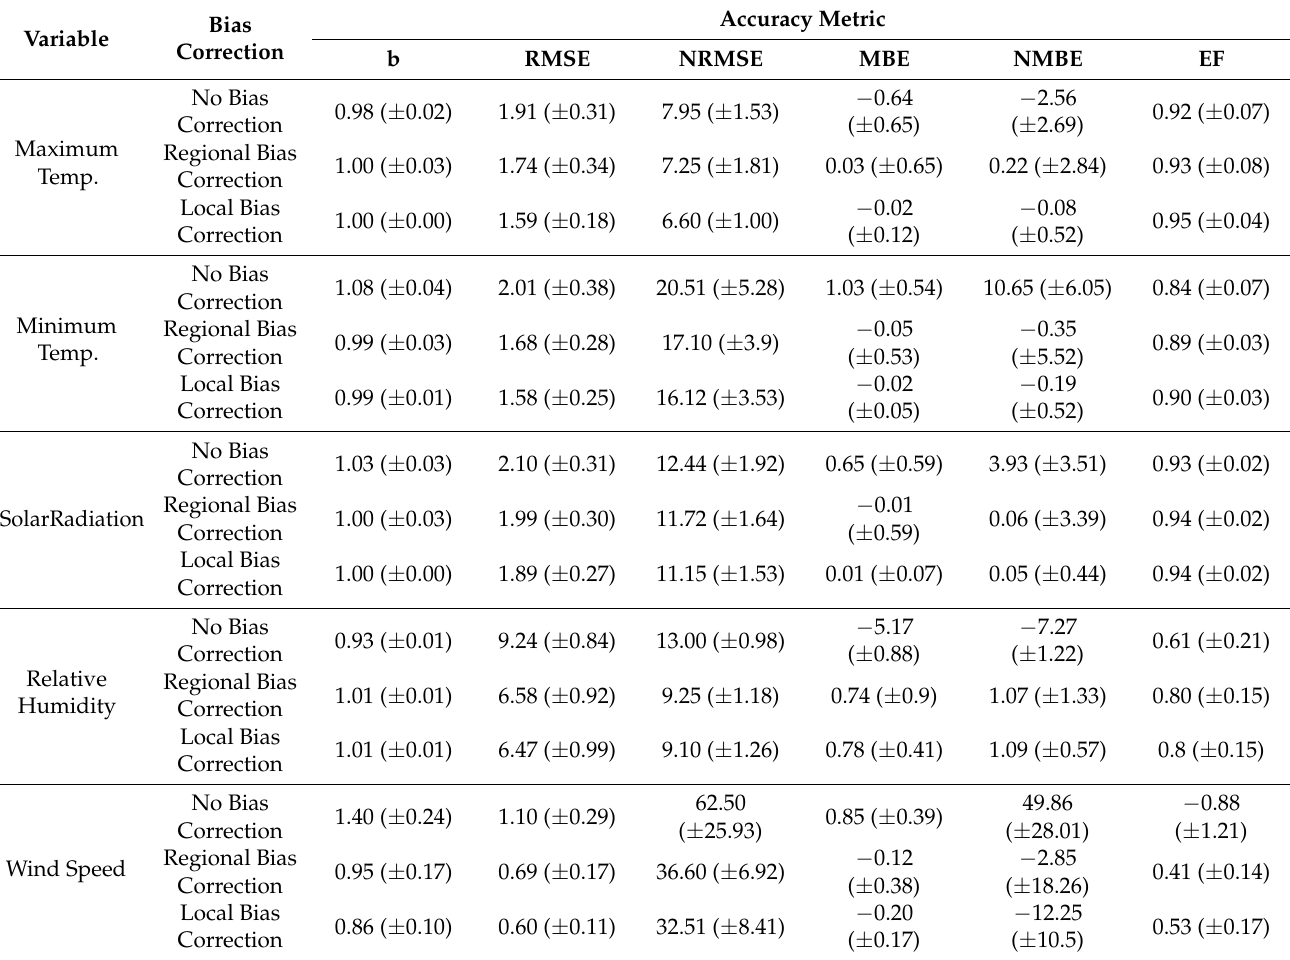
Table 9. Mean and standard deviation values of all the accuracy metrics relative to NASA POWER weather variables, with and without bias